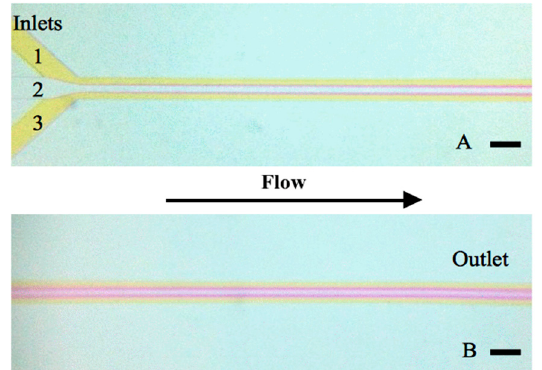
Figure 9. Conventional, planar microfluidic T-shape device with rectangular cross section used for nanoparticle self-assembly in [29]. The width is 200 μ m, the height is 45 μ m and the length from channel joint ( top left ) to outlet ( bottom right ) is 15 mm. Note the very slow diffusive mixing from inlet to outlet, evidenced by a maintained color difference even at the outlet of the device. Flow rates of 1 mL/h Phenol red (inlet 1 , 3 ) and 0.5 mL/h NaOH (inlet 2 ) are used. The scale represents 200 μ m. Note that due to laminar flow characteristics, mixing occurs only slowly along the channels.